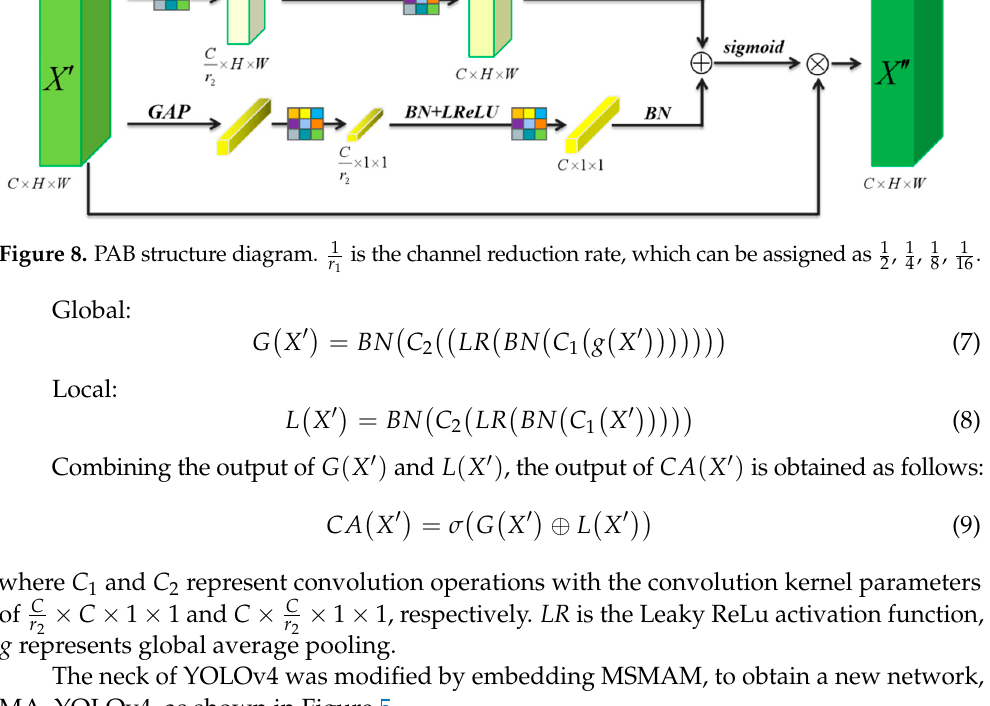
, (cid:2869) , (cid:2869) (cid:2870) (cid:2872) (cid:2876)